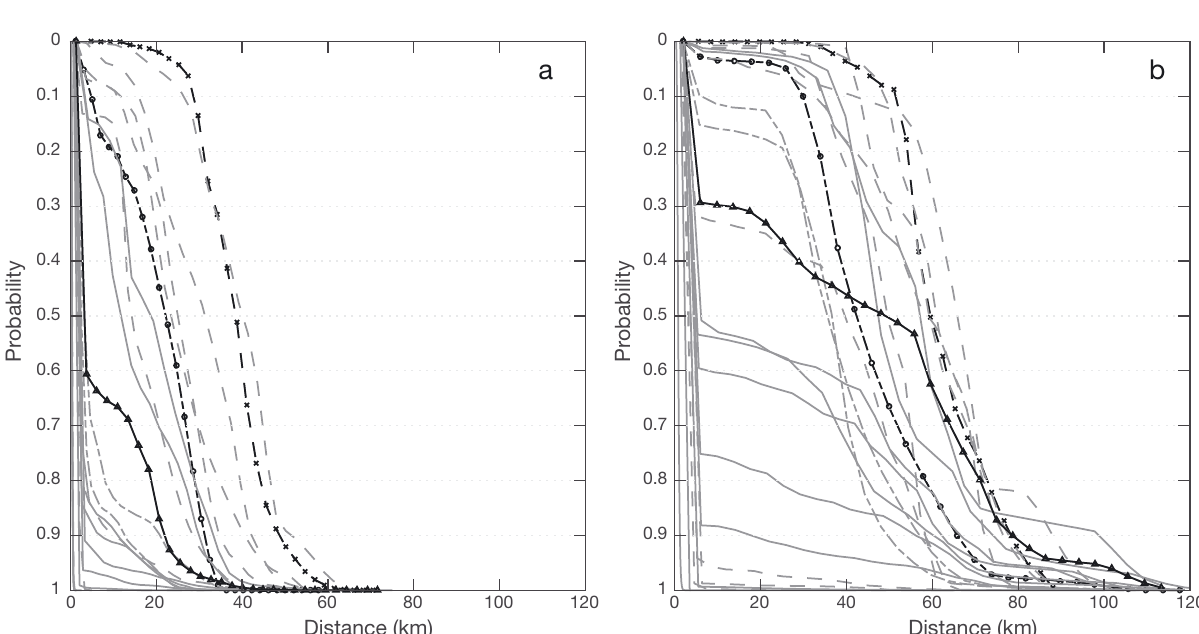
Fig. 5. The cumulative frequency of the maximum Euclidean distance attained by (a) nauplii and (b) copepodid particles re- leased from all 24 sites. (Grey dash-dotted lines) Farms 1 to 3, (grey dashed lines) Farms 4 to 13, and (grey solid lines) Farms 14 to 24. As examples, 3 farms are highlighted: (dash-dotted line with circle) Farm 2, (dashed line with cross) Farm 5, and (solid line with triangle) Farm